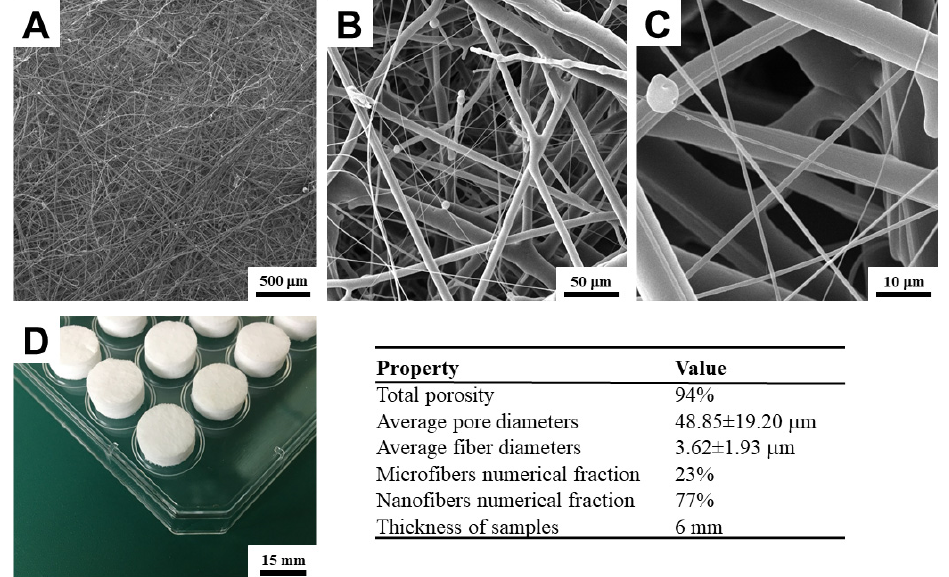
Figure 2. Manufactured 3D scaffolds combining micro- and nanofibers. ( A – C )—scaffold morphology observed with SEM. ( D )—the image of scaffolds in the form of discs. Table—structural parameters of the material [17].